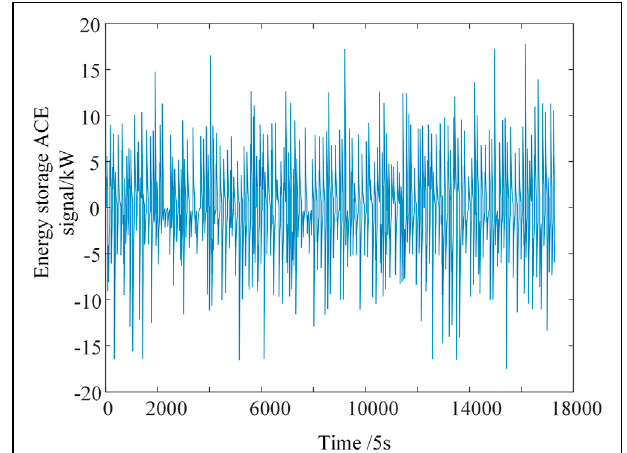
FIGURE 4 | Hybrid energy storage system’s P s − b